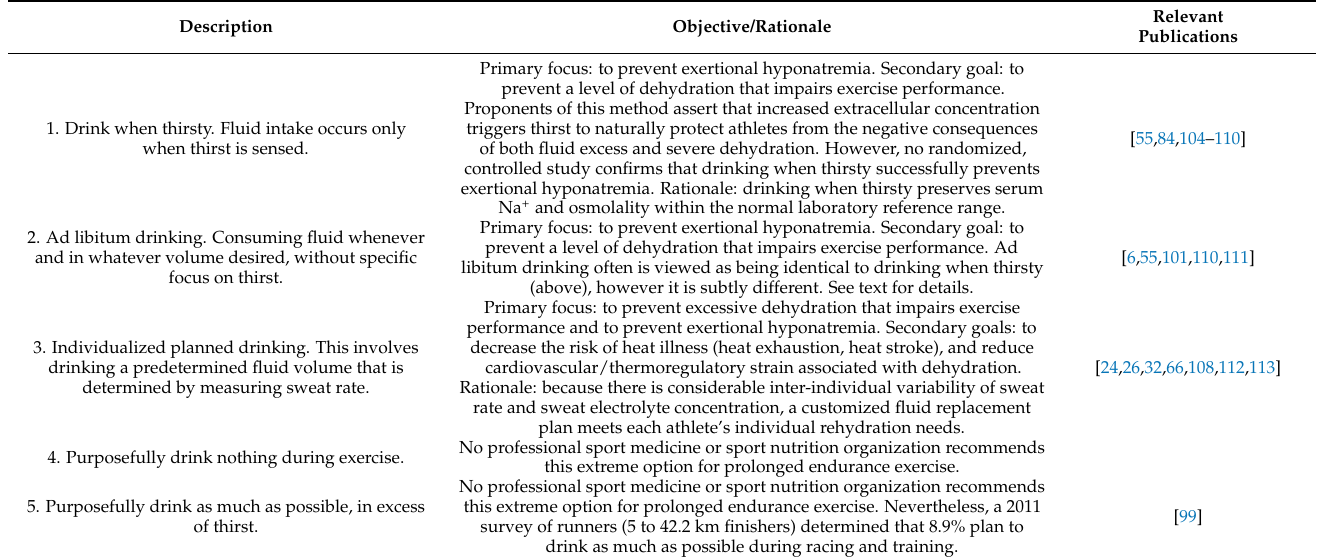
Table 5. Five options for rehydration during endurance